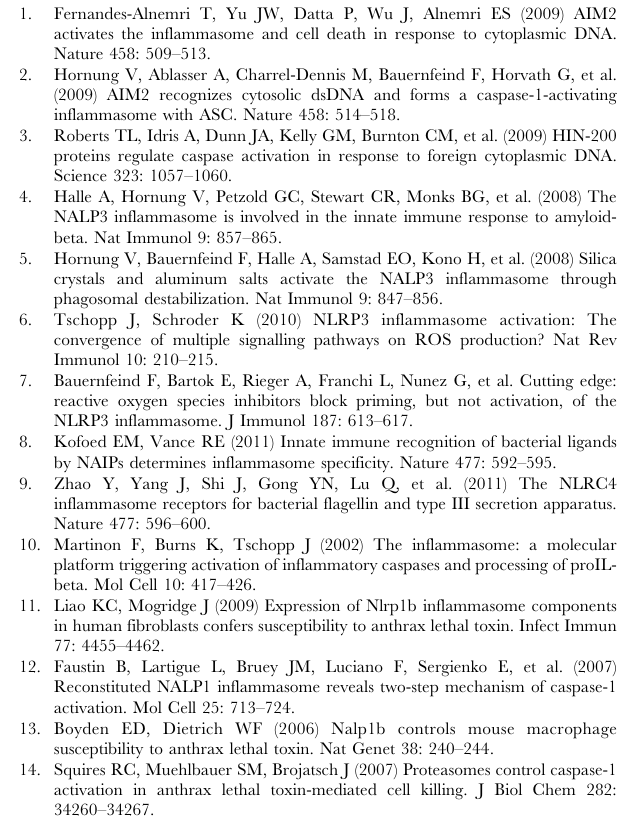
Figure S1 The S984A mutation in Nlrp1b1 eliminates both cleavage and inflammasome activity. (A)